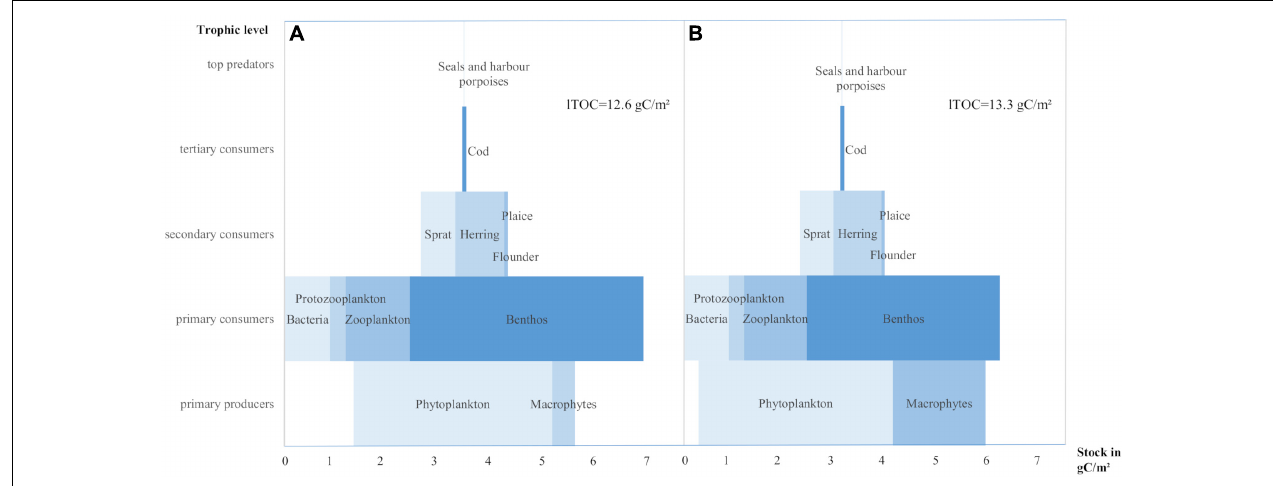
FIGURE 6 | Carbon stocks per trophic level valid for the entire Baltic Sea area. (A) With the macrophytes covering 2,020 km 2 and benthos 349,349 km 2 (areas < 2 mlO 2 /l) and total living carbon (lTOC) of 12.6 gC/m 2 . (B) With macrophytes covering 8,400 km 2 (2% of entire Baltic Sea area) and benthos 295,105 km 2 (areas < 3 mlO 2 /l) and lTOC of 13.3 gC/m 2